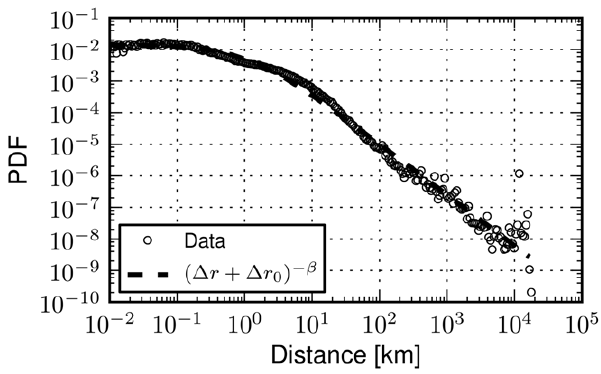
Figure 1. Global movements. The probability density function (PDF) of human displacements as seen through 35 million location broadcasts (check-ins) across the planet. The power-law fit features an exponent b ~ 1 : 50 and a threshold D r 0 ~ 2 : 87 confirming previous works on human mobility data. The spatial granularity offered by GPS data allows for the inspection of human movements at very small distances, whereas the global reach of Foursquare reveals the full tail of the planetary distribution of human movements.